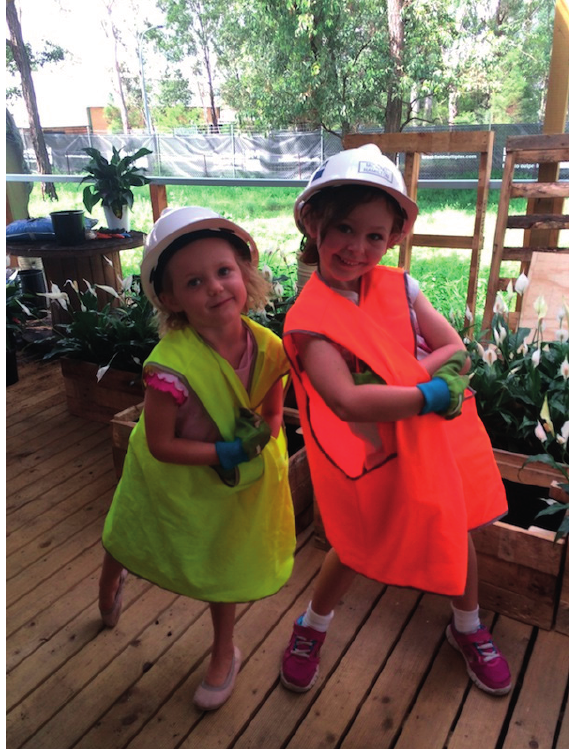
Figure 3. Children actively participating with their parents in the working